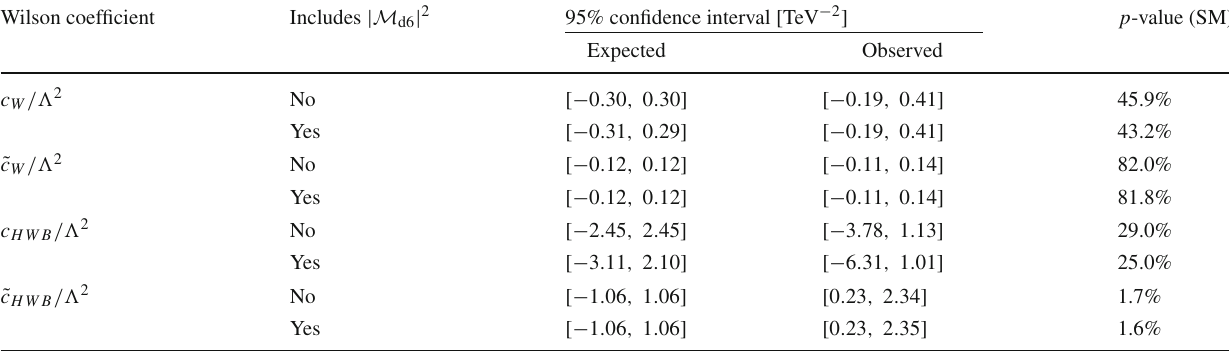
Table 4 Expected and observed 95% confidence interval for the four Wilson coefficients, using fits to the EW Zjj differential cross-section measured as a function of (cid:4)φ jj . Results are presented when including or excluding the pure dimension-six contributions to the EFT prediction. The p -value quantifying the compatibility with the SM hypothesis is also shown for each Wilson coefficient. The global p -value associated with constraining these four Wilson coefficients is investigated using pseudo-experiments, as outlined in the